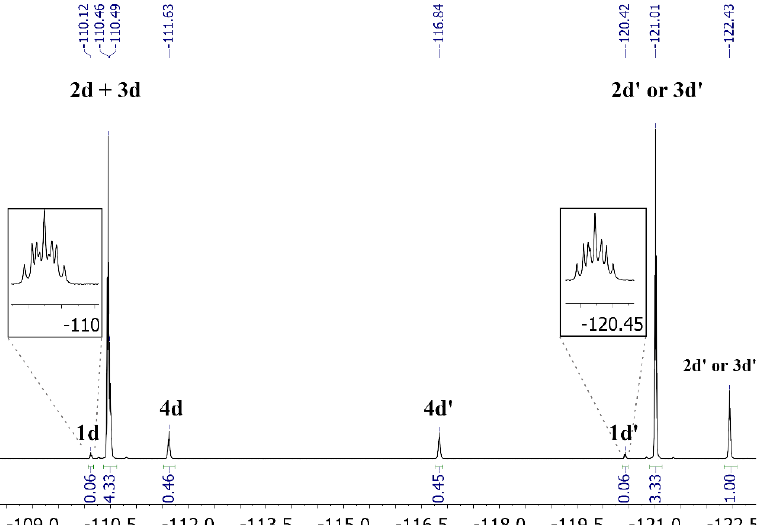
Figure 1. 19 F NMR (470 MHz, acetone-d 6 cap.) spectrum at 283 K from the silylation reaction of 1d with N,O-bis (trimethylsilyl) acetamide (BSA) in DMAc. The quotation mark ( ′ ) depicts the fluorine atom on the right in the structures shown in Scheme 2.